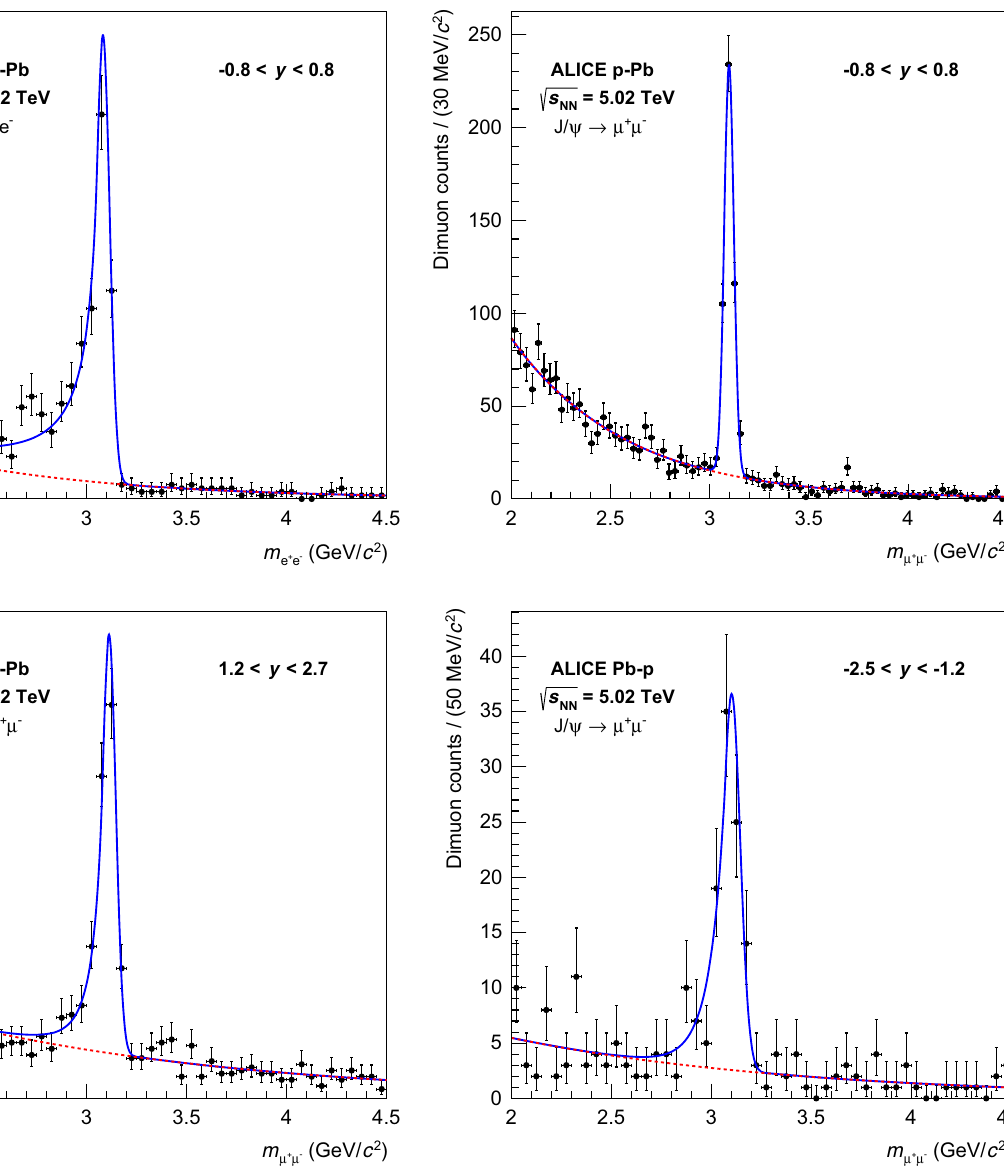
Fig. 1 Mass distributions of selected dileptons for the dielectron (upper left) and dimuon (upper right) samples for the central analy- sis and dimuon samples for the semi-forward (lower left) and semi- backward (lower right) analyses. In all cases the data are represented